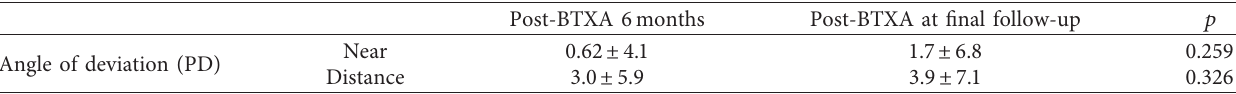
Table 5: Post-BTXA 6 months and Post-BTXA at final follow-up comparison in patients with AACE.